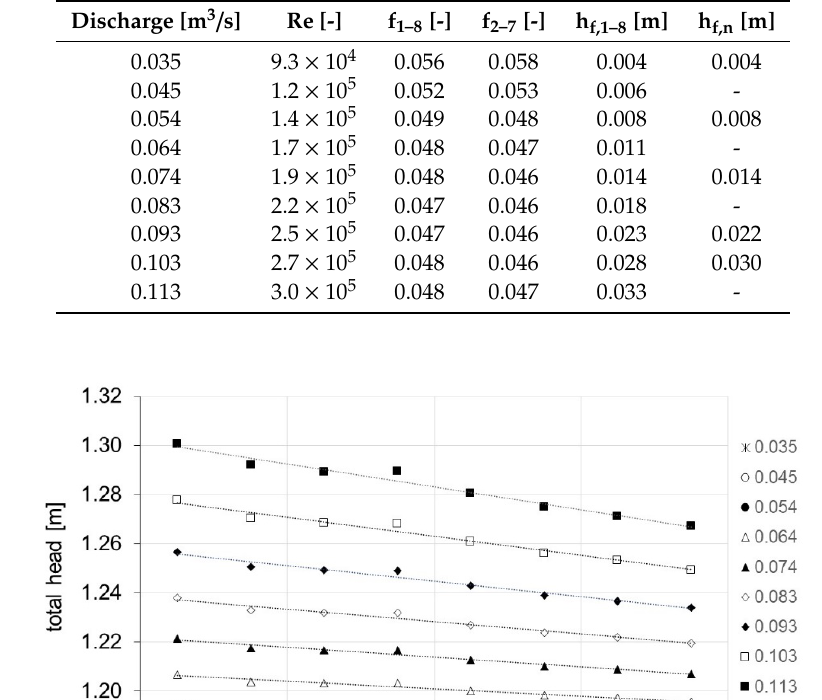
Table 3. Friction factors f and head losses determined from the pressure measurements for the reaches 1–8 and 2–7, and h f,n from the five numerical simulations (between cross sections 1–8).